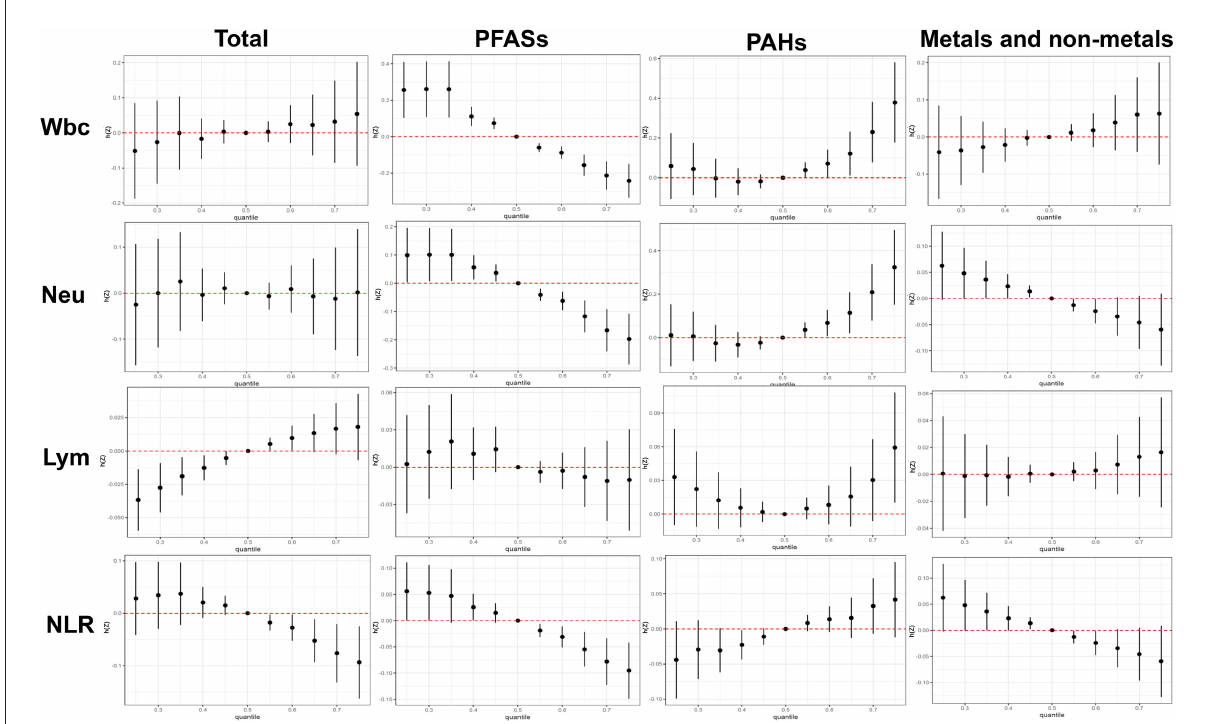
FIGURE3 Combined effects of the total chemical mixtures and different subgroups (PFASs, PAHs, Metals and non-metals) on Wbc, Neu, Lym, and NLR when all the chemicals were held at particular percentiles compared to their medians. The results were assessed by the BKMR model and adjusted for age, gender, ethnicity, education levels,